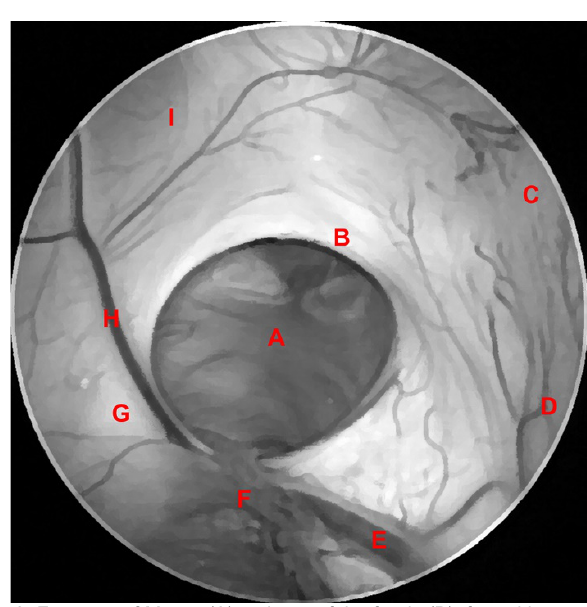
Fig. 6. Foramen of Monro (A), column of the fornix (B), frontal horn (C), head of the caudate nucleus (D), superior thalamostriate vein (E), choroid plexus (F), body of the fornix (G), anterior septal vein (H), septum pellucidum (I).